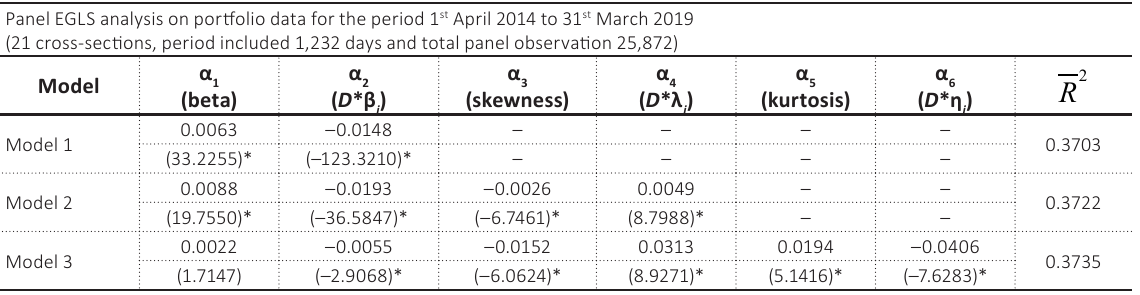
Table 4. Estimates of risk premium in conditional pricing models